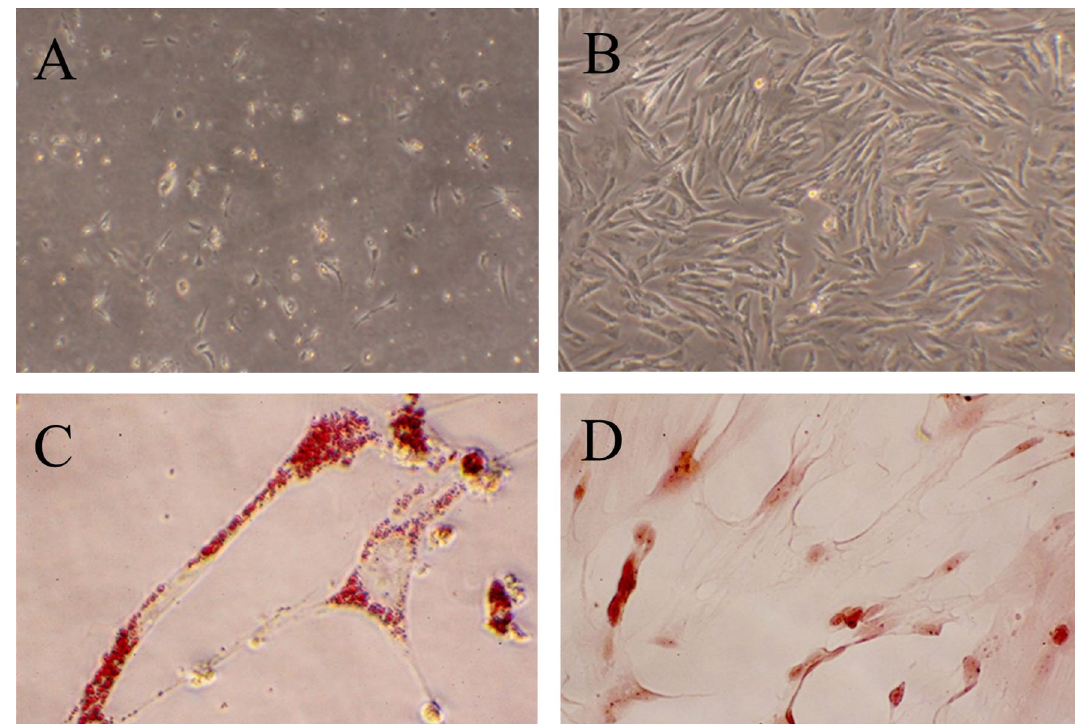
Figure 2. Isolation and identification of ADSCs. ( A ) Primary ADSCs (× 100); ( B ) Three generations ADSCs (× 100); ( C ) Oil Red O staining (× 400); ( D ) Alizarin Red Staining